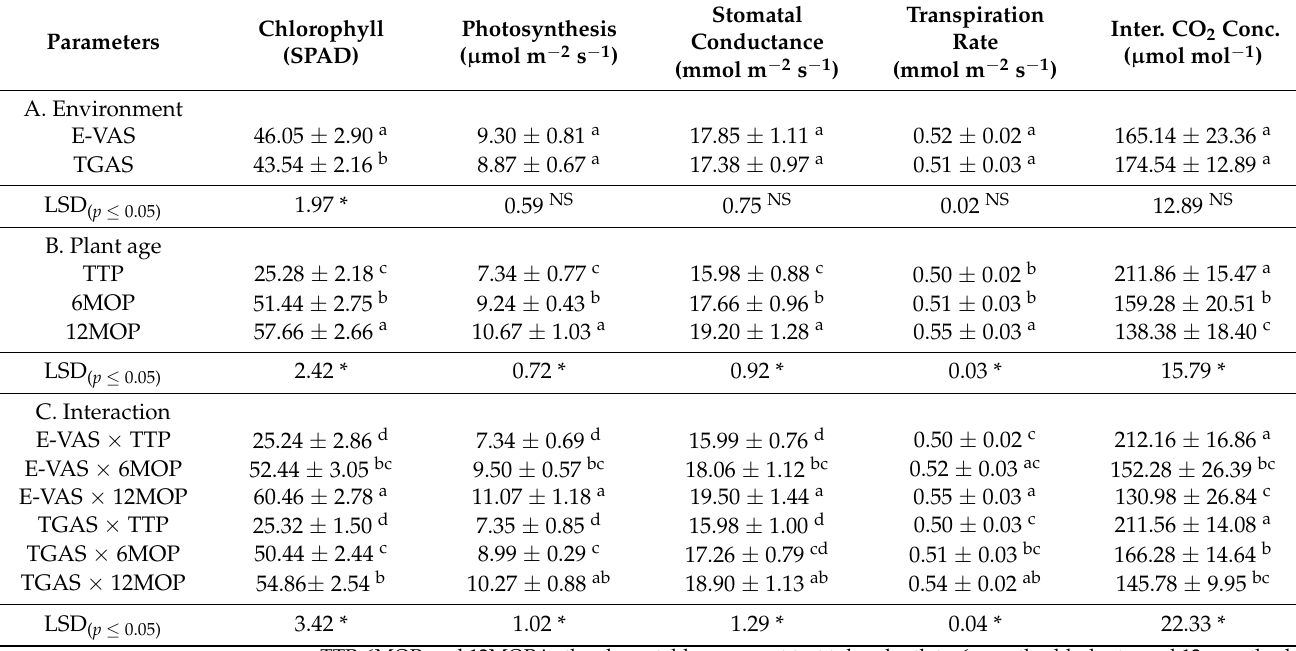
Table 4. Physiological response of different-aged tissue culture-derived date palm (cv. Khalas) plants under ex vitro acclimatization system (E-VAS) and traditional glasshouse acclimatization system (TGAS) environment for